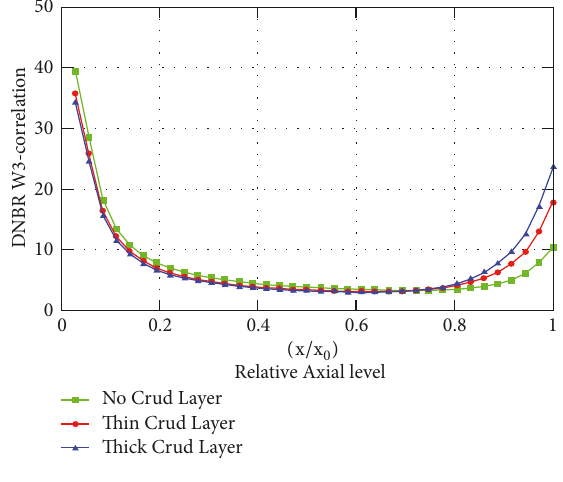
Figure 8: The DNBR distribution along the assembly.